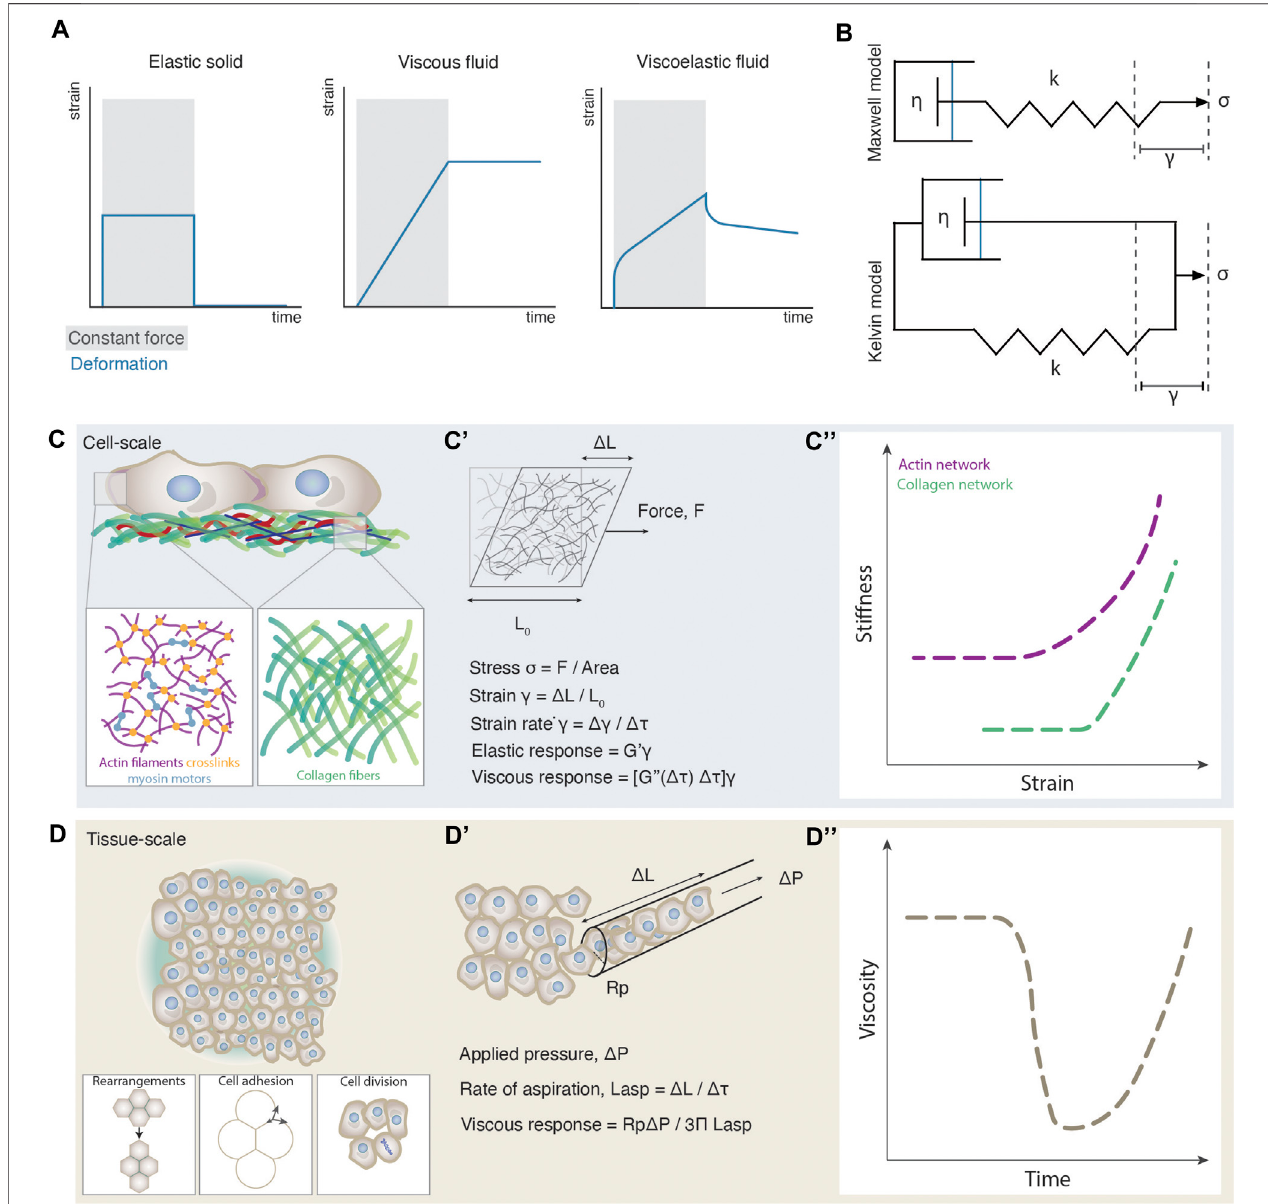
FIGURE 1 | Emergence of cell and tissue viscoelasticity. (A) Strain plots as a function of time for different materials during constant force application (grey shaded box)andrelease. (B) SchematicillustrationsoftheMaxwellandKelvinviscoelasticmodels.IntheMaxwellmodel(top)thespringanddashpotareconnectedinseriesand account for the behaviour of viscoelastic fl uid materials. In the Kelvin model (bottom) the spring and dashpot are connected in parallel and account for the behaviour of viscoelastic solidmaterials.Stress σ isapplied alongtheaxis ofthespringtriggering astrain c . k isthespring constantand η isthe viscosity ofthe fl uid. (C) Cellular- scale viscoelasticity is de fi ned by the cytoskeletal network and extracellular matrix. The close ups illustrate an exemplary composition of an actin and collagen network. (C ’ ) Schematicillustrationofanexperimentallyinduceddeformationofacytoskeletalnetworkandaparadigmofhowviscoelasticpropertiescanbecomputedfromsuch experiments. (C ” ) Stiffness-strain plots of actin and collagen networks exhibiting a non-linear increase of their elastic modulus, or a stress-stiffening response. The plot wasadapted from [71, 141]. (D) Tissue-scale viscoelasticity isdetermined by several cellular processes such as cell rearrangements, cell-cell adhesion and cell division. (D ’ ) Schematic illustration of an experimentally induced deformation of an embryonic tissue using micropipette aspiration and a paradigm of how viscoelastic properties can be computed from such experiments. (D ” ) Plot of the nonlinear decrease of tissue viscosity as observed during zebra fi sh morphogenesis. F , Force; σ , stress; c , strain; G ’ , elastic modulus; G ’’ , viscous modulus; Δ P , applied pressure; Δ L , deformation length; R p , pipette radius.